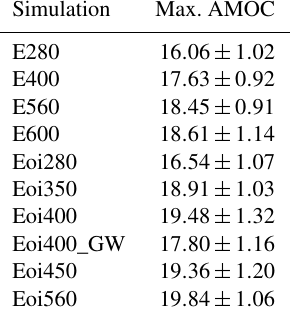
Table 4. Time average and variability of the maximum of the At- lantic Meridional Overturning Circulation (AMOC) in Sverdrups imum of the basin-wide zonal- and time-integrated stream function in the Atlantic Ocean between 500 and 1500m of depth north of 20 ◦ N. Time variability indicated as ± 1standard